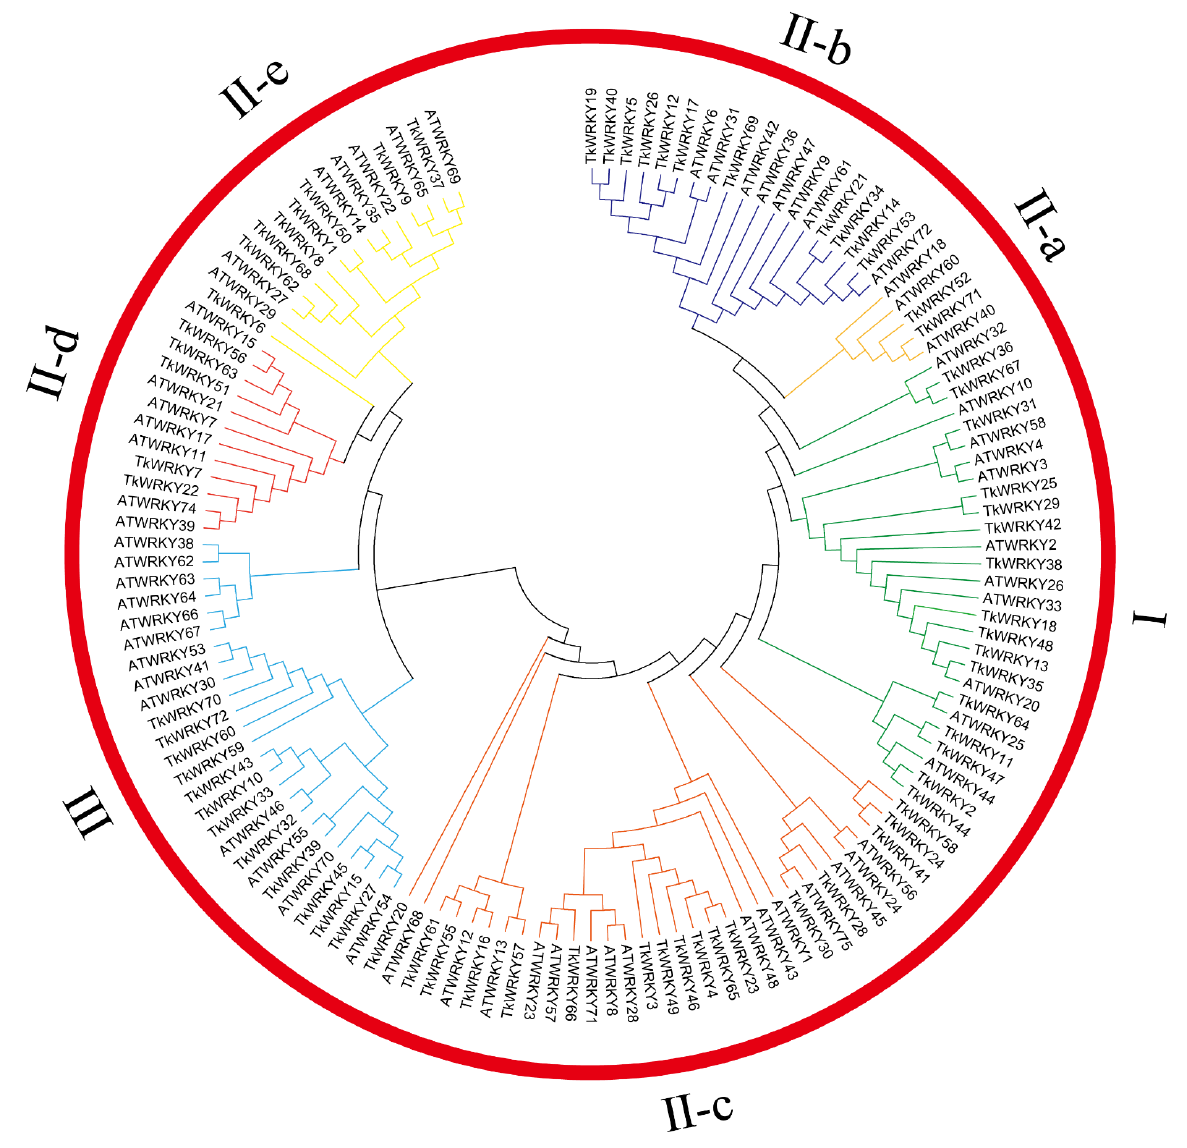
Figure 3. The phylogeny of Arabidopsis and Taraxacum kok-saghyz Rodin TF s . The phylogenetic tree is divided into groups I, II-a, II-b, II-c, II-d, II-e, and III with green, dark yellow, dark blue, orange, red, yellow and blue marking the clusters, respec-